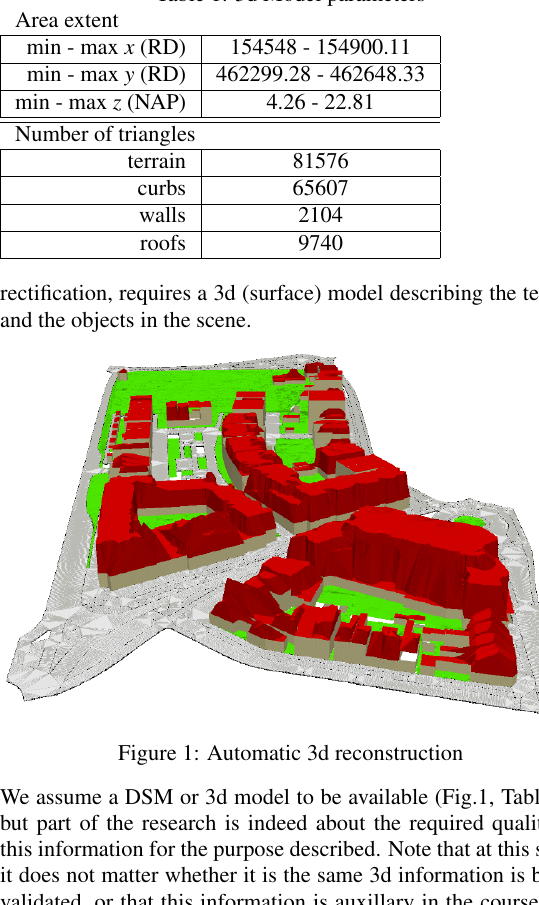
Table 1: 3d Model parameters